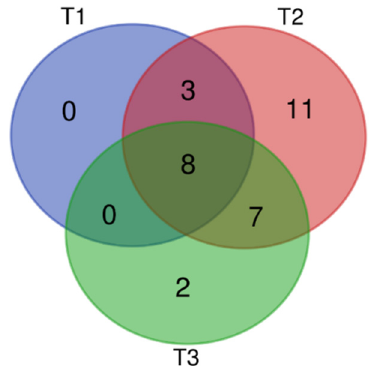
Figure 1. Venn analysis of volatile organic compounds (VOCS) of L. caudata at three flowering stages. T1: pre-blooming stage; T2: full-blooming stage; T3: over-blooming stage. Aldehydes accounted for 89.95% of the total amount of aroma substances and were the most abundant aroma components at the pre-blooming stage (T1). They also ac- counted for 34.14% in the over-blooming stage (T3), but made up only 6.02% of the total aroma content during full-blooming stage (T2). Alcohols were one of the main aroma com- ponents during the flowering stage of L. caudata . Among them, 2-nonanol (20.86%) had the highest content in the full-blooming period and the content of 1-hexanol (32.23%) was the highest at the over-blooming stage. Interestingly, the content of monoterpenes (38.22%) in the full-blooming stage was apparently higher than that in the over-blooming stage (3.12%) and the pre-blooming stage (0.00%) (Figure 2). The main monoterpenes were nerol (17.36%), geraniol (6.32%), and linalool (5.34%). Of the 16 monoterpenoids detected, 11 were detected only in the full-blooming stage. This showed that monoterpenoids were the key to distinguishing the components in bloom from those in the pre-blooming stage and the over-blooming stage (Figure 3). The total amount of aromatic substance released dur- ing the blooming period of L. caudata was 140.90 ng g − 1 min − 1 , which is significantly higher than that during the pre-blooming stage (36.54 ng g − 1 min − 1 ) and the over-blooming period (24.92 ng g − 1 min − 1 ). From the pre-blooming stage to the over-blooming stage, the total amount of volatile compounds released showed an initial increase followed by a decrease. Figure 2. Relative content of volatile categories of L. caudata in three flowering stages. T1: pre-bloom- ing stage; T2: full-blooming stage; T3: over-blooming stage.